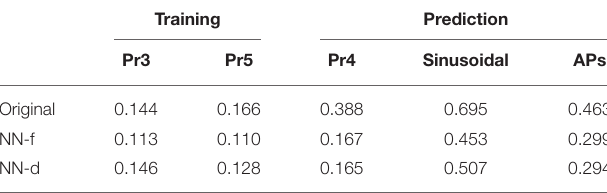
TABLE 1 | Mean absolute error of the model simulations for the synthetic data study. Training Prediction